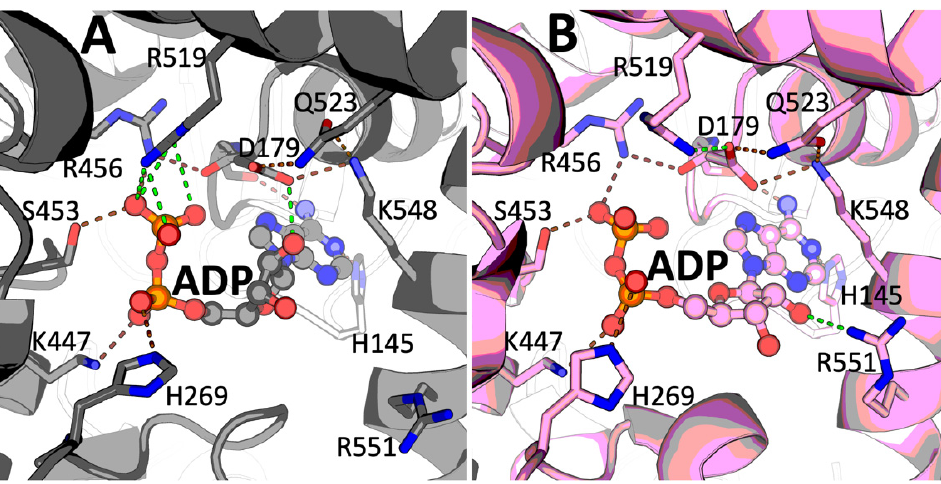
Figure 3. Comparison of ADP binding in the new GDH ∙ ADP complex of 2.4-angstrom resolution ( A ) and previously reported complex 6DHK ( B ). ( A )—The C2 ′ -endo conformation of the ADP in the 8AR8 structure, shown in gray. ( B )—The C3 ′ -endo conformation of the ADP in the 6DHK (3.5-angstrom resolution) structure, shown in pink. Similar ADP bonds in both structures are shown by brown dashed lines, and the green lines indicate the differences between the 8AR8 and 6DHK entries.